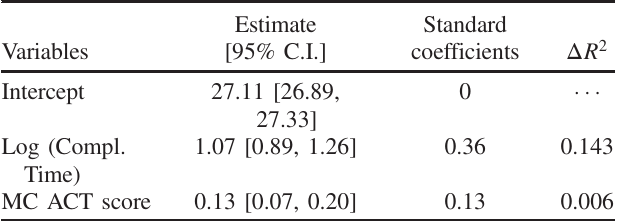
TABLE III. Results of model 1 predicting the nonexam component of a student ’ s grade, ranging from 0 – 30 (percent), with the student ’ s (mean-centered) ACT score and the log of their average completion time as the independent variables. The estimates of the coefficients are presented with 95% confidence intervals. The Δ R 2 column corresponds to the increase in R 2 as the model was forward